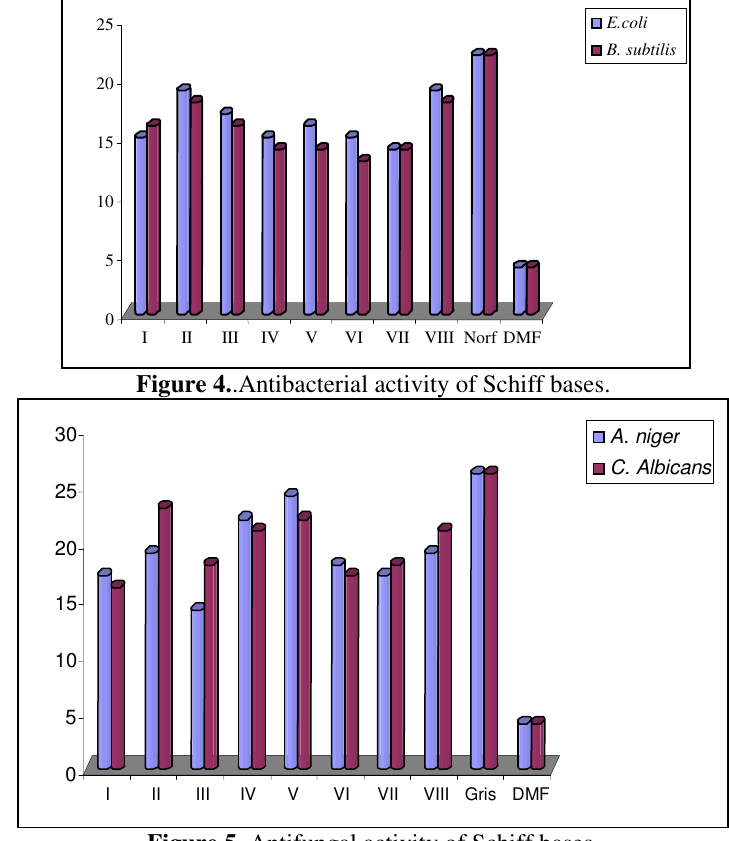
Figure 5. Antifungal activity of Schiff